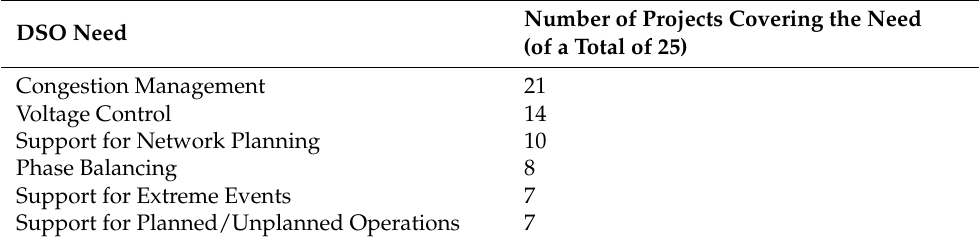
Table 3. Number of initiatives addressing each identified DSO need.